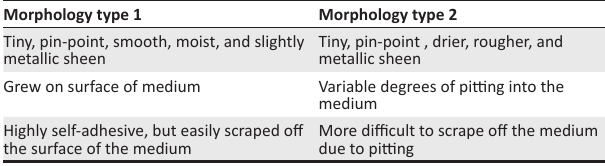
TABLE 3: Two different colony morphologies observed for the rodent isolates. Morphology type 1